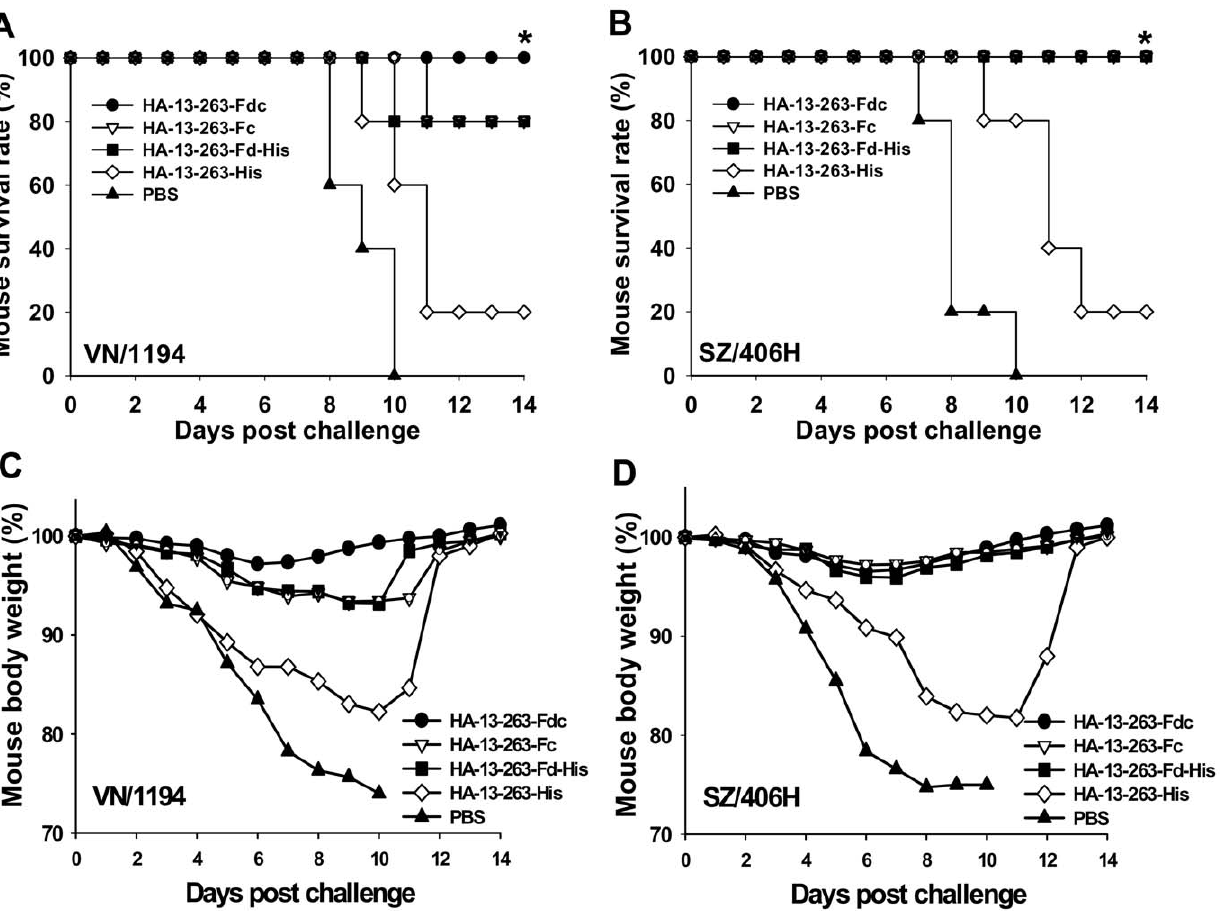
Figure 8. Comparison of cross-protective activity of HA-13–263 proteins against lethal H5N1 virus challenge. PBS was used as the control. Survival rate (%) of mice vaccinated with HA-13–263 proteins challenged with lethal dose of H5N1 virus from VN/1194 (clade 1) (A) and SZ/ 406H (clade 2.3.4) (B). * indicates significant difference ( P , 0.05), respectively, between HA-13–263-Fdc and HA-13–263-His group, or PBS control, for VN/1194 virus, and between HA-13–263-Fdc, HA-13–263-Fc, or HA-13–263-Fd-His vaccination groups and HA-13–263-His group, or PBS control for SZ/406H virus. Percentage of body weight change (%) of HA-13–263-vaccianted mice after challenge with VN/1194 (C) and SZ/406H (D) H5N1 virus was